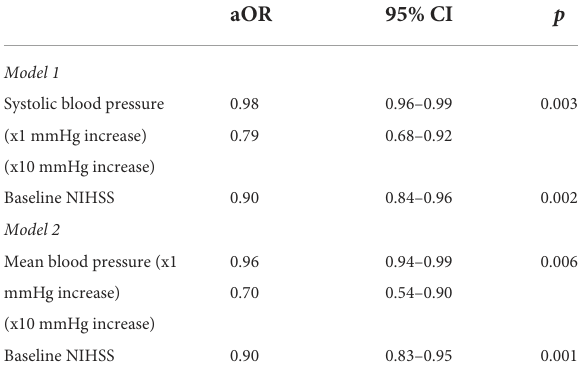
TABLE 2 Results of the multivariable ordinal logistic regression analysis of predictors of good collaterals classified by collateral score (CS) categories.